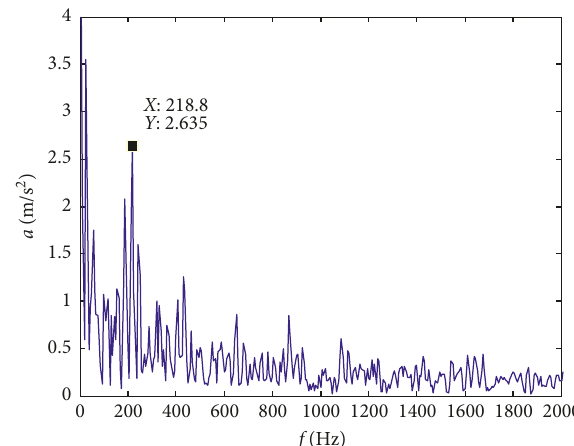
Figure 23: The envelope spectrum of the last file data of Case